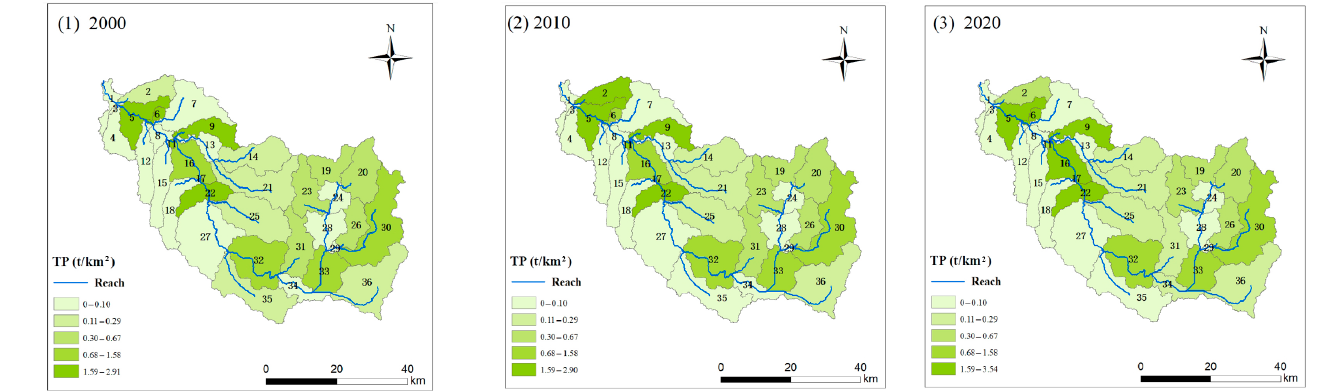
Figure 21. Average annual load of total phosphorus per unit.